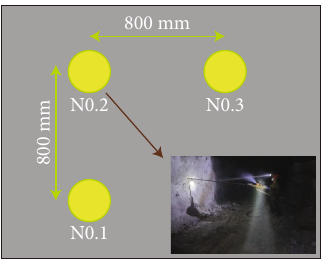
Figure 5: Location of test anchors and fi eld tests.